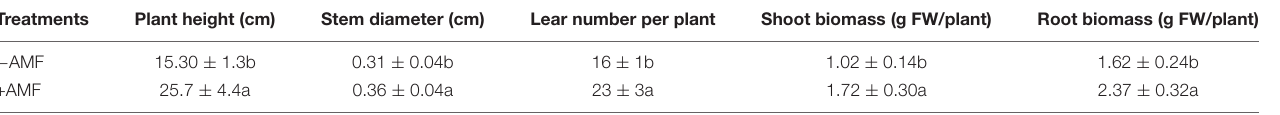
TABLE 1 | Plant growth of trifoliate orange seedlings inoculated with Funneliformis mosseae before soil moisture deficit stress (SMDS). Treatments Plant height (cm) Stem diameter (cm) Lear number per plant Shoot biomass (g FW/plant)